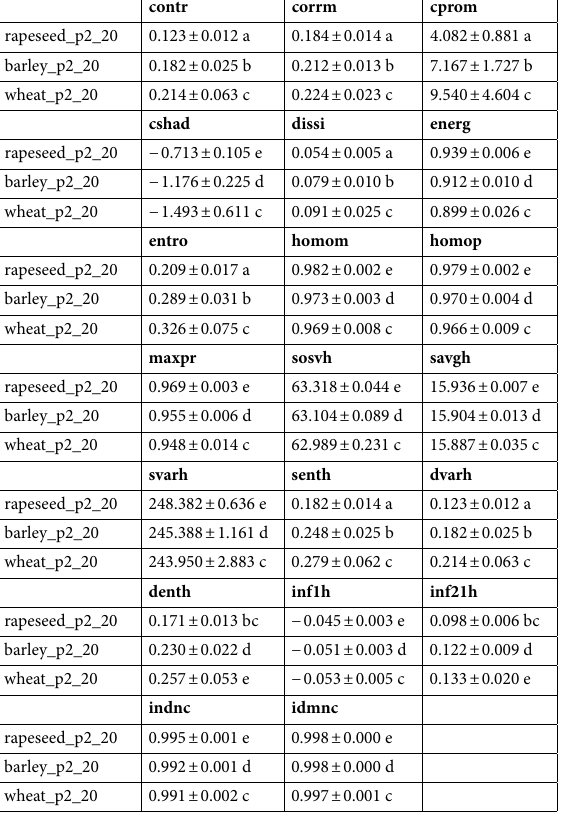
Table 7. Texture analysis of kernels for selected air stream velocities (20 m s −1 ) and the position of the seed-air tube of type II. a–e: the differences between mean values with the same letter in columns were statistically insignificant ( p <